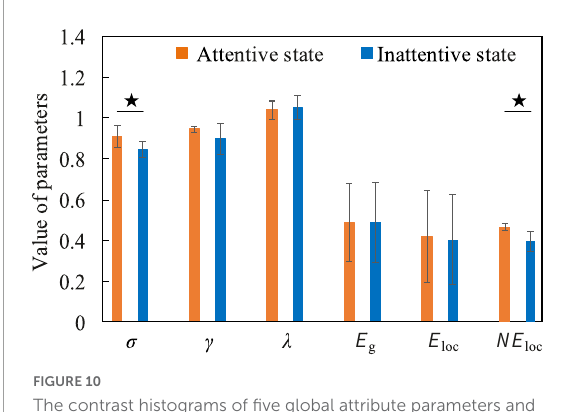
FIGURE10 The contrast histograms of five global attribute parameters and one local attribute parameter of the functional brain network in the attentive and inattentive states.